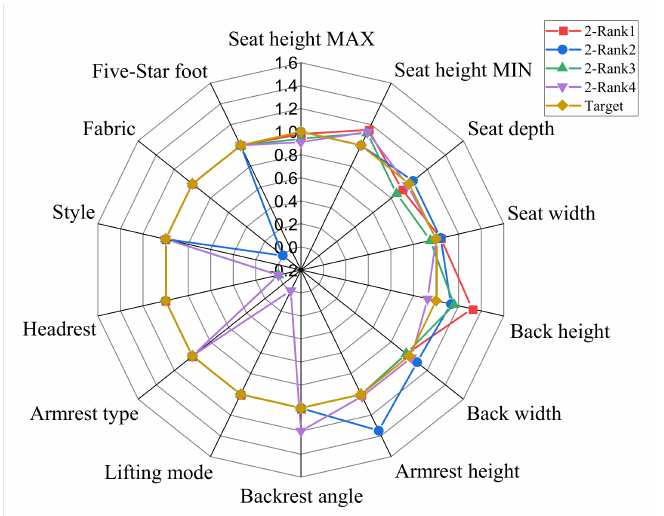
Figure 6. The results of weighted K-NN office chair type